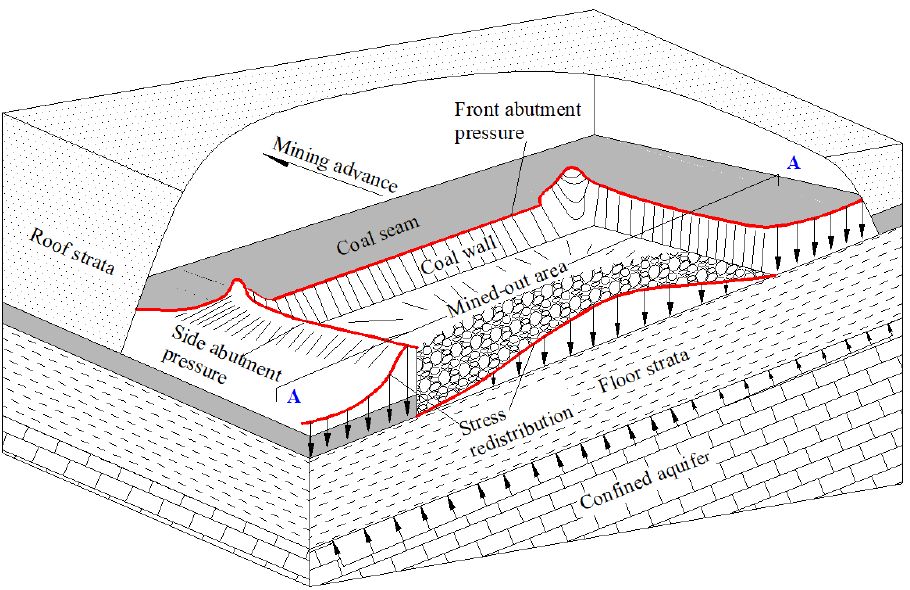
Figure 2. Spatial redistribution of mechanical loads on the seam floor above an aquifer. A-A represents the section along the inclination.